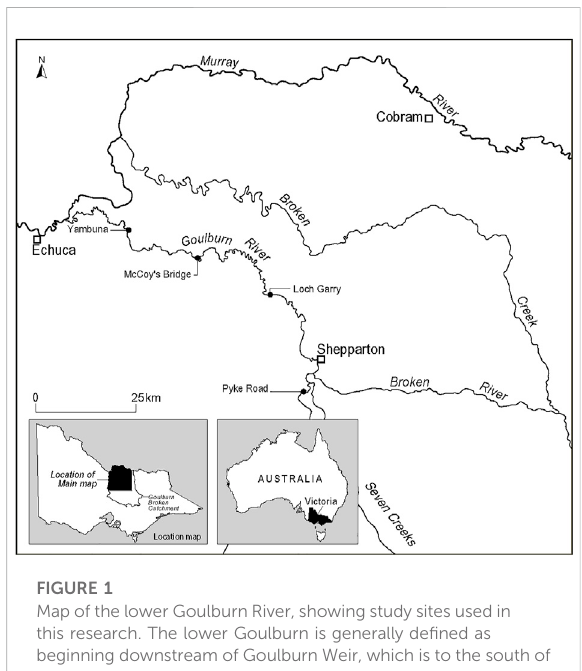
FIGURE 1 Map of the lower Goulburn River, showing study sites used in this research. The lower Goulburn is generally de fi ned as beginning downstream of Goulburn Weir, which is to the south of the mapped portion of the river. Insets illustrate the location oftheGoulburn-BrokencatchmentwithinthestateofVictoriaand within